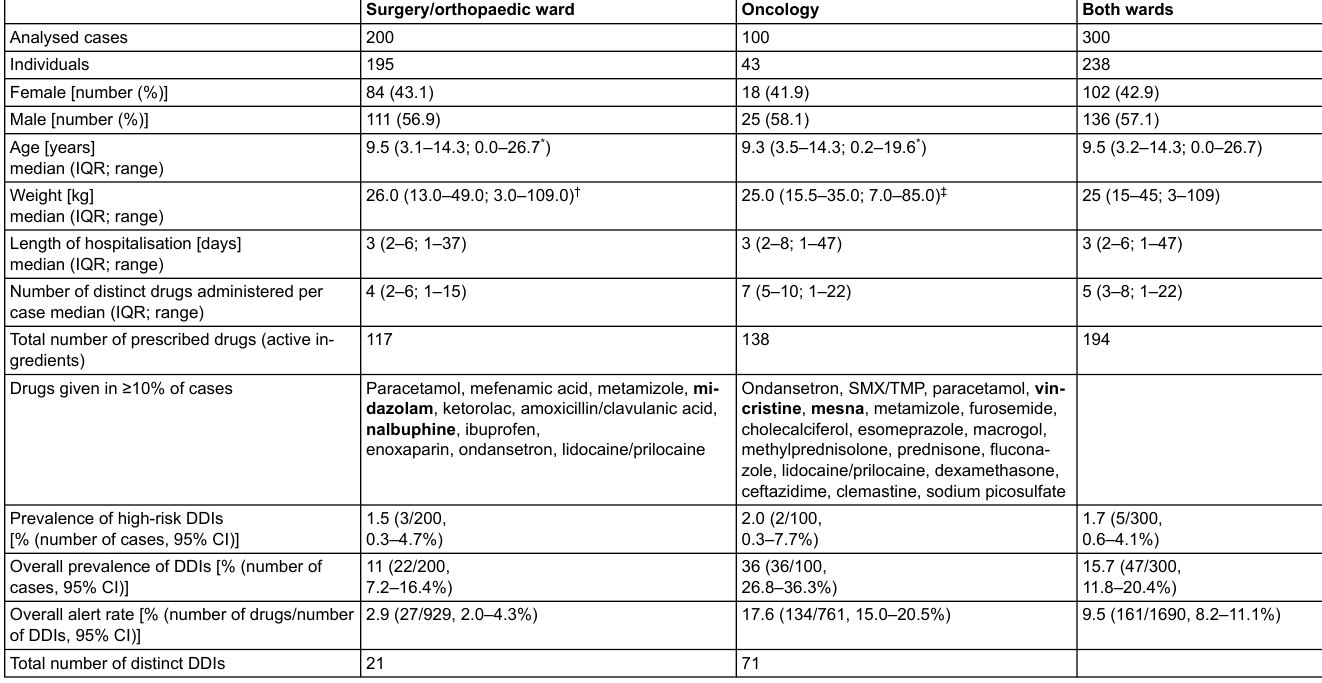
Table 1: Patient demographics and summary of drug use and detected drug-drug interactions (DDI). Surgery/orthopaedic ward Oncology Both wards